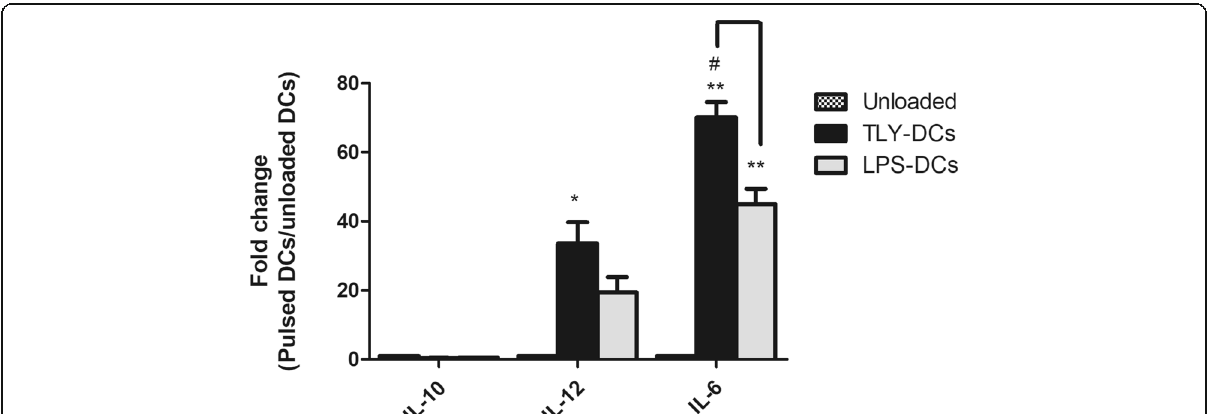
Fig. 8 Alteration in the gene expression profile of IL-10, IL-12 P40 and IL-6 before and after tumor lysate pulsing of dendritic cells. The data show the fold change between loaded /unloaded DCs. The data were normalized to GAPDH mRNA expression level. # P <0.05 represents the significant difference from LPS -DCs. * P <0.05, ** P <0.01, and *** P <0.001 represent significance to unloaded DCs. The data are given in mean value ± SEM of three experiments comprising three different healthy donors. iDCs, immature dendritic cells; TLY, tumor lysate; LPS,